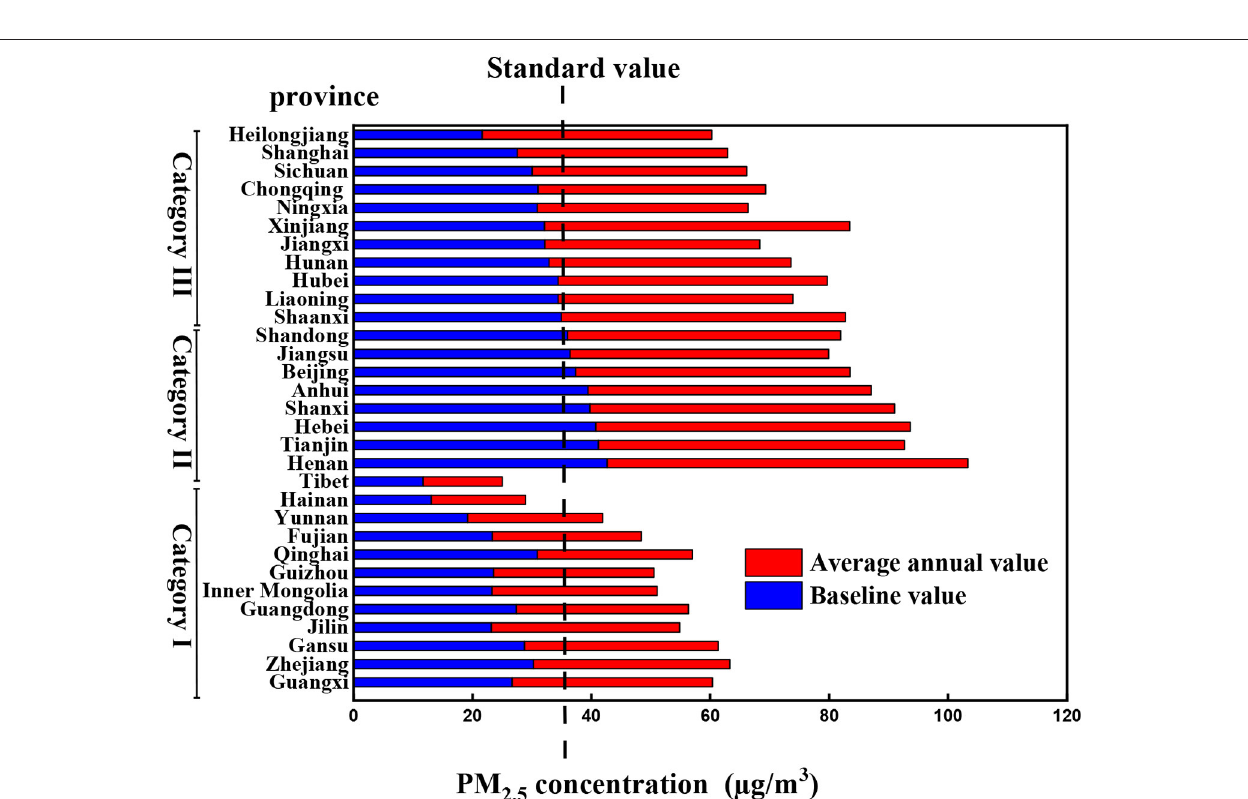
to the baseline value and strive to minimize the emission of PM 2.5 . The baseline value and monitoring value of the second category of provinces are higher than the